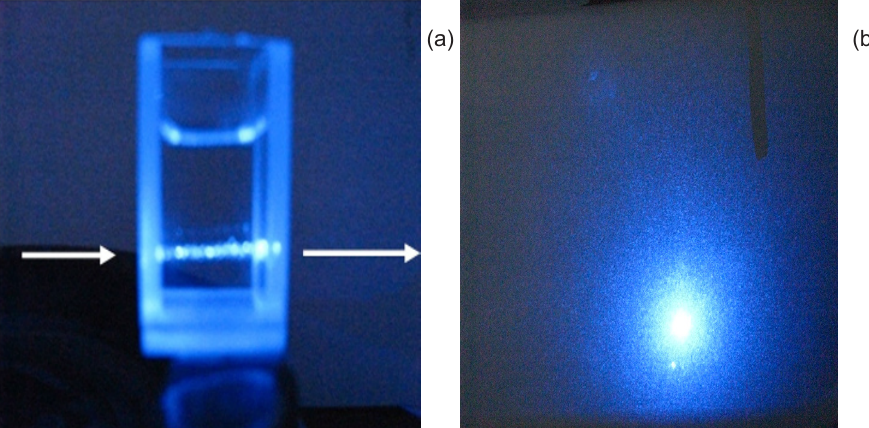
Figure 3. Flux of blue beam: a) throught 0.1 mol L –1 Tl